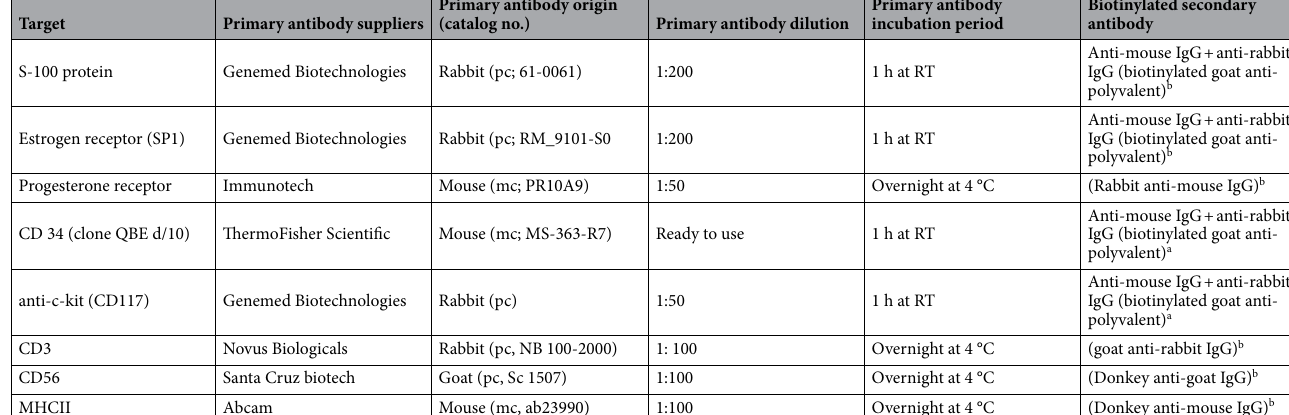
Table 1. Identity, sources, and working dilutions of primary and secondary antibodies. pc polyclonal, mc monoclonal, RT room temperature. a From ThermoFisher Scientific/Lab Vision, Fremont, CA, USA. b From Dako, Hamburg,